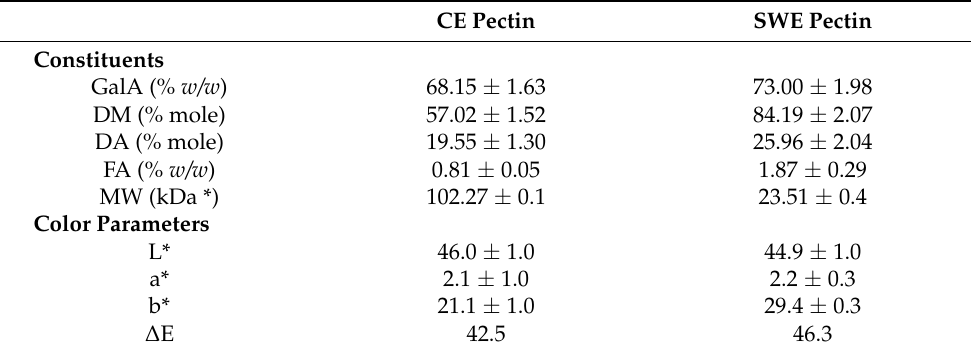
Table 2. Constituents and color parameters of pectin obtained under the optimum condition by conventional extraction (CE) and